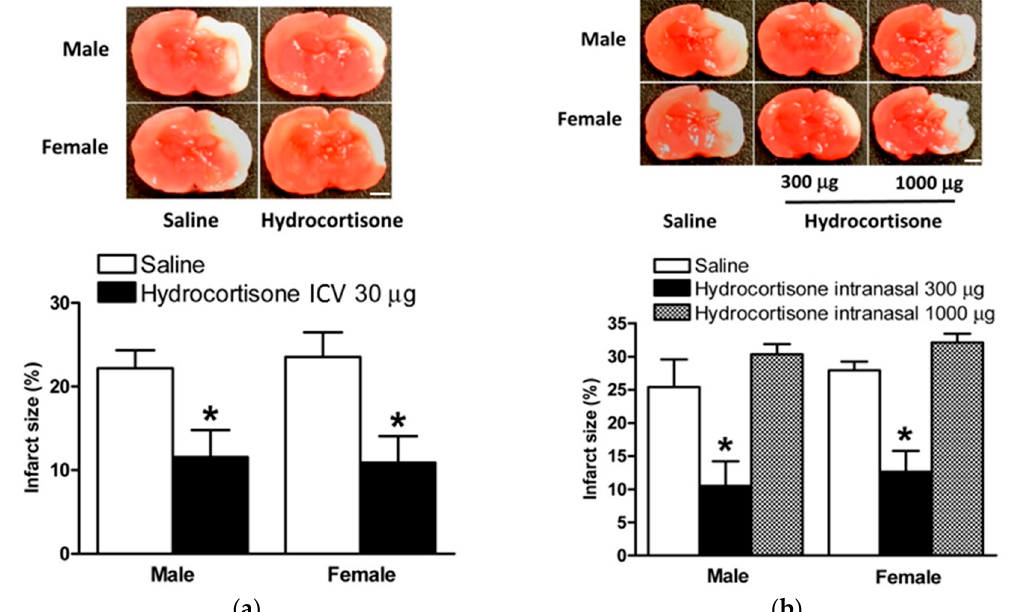
Figure 5. Hydrocortisone protects neonatal rat brain after LPS sensitization and HIE. LPS 0.05 mg/kg via i.p. injection administered on postnatal day 3 (PND3) and 5 (PND5) with HI injury conducted on PND7. Hydrocortisone via ICV injection or intranasal instillation administered 2 h after HIE insult. Representative brain slices are shown above. ( a ) Hydrocortisone, 30 µg, ( n = 16) via ICV injection significantly reduced brain infarct size in both male and female rat pups vs. controls ( n = 22); and ( b ) hydrocortisone, 300 µg, ( n = 18) via intranasal administration significantly reduced brain infarct size in both male and female rat pups vs. controls ( n = 13). No significant difference was seen comparing hydrocortisone, 1000 µg, ( n = 9) vs. saline ( n = 13) via intranasal administration. Data are means ± SEM, * p < 0.05. Scale bars, 2 mm.